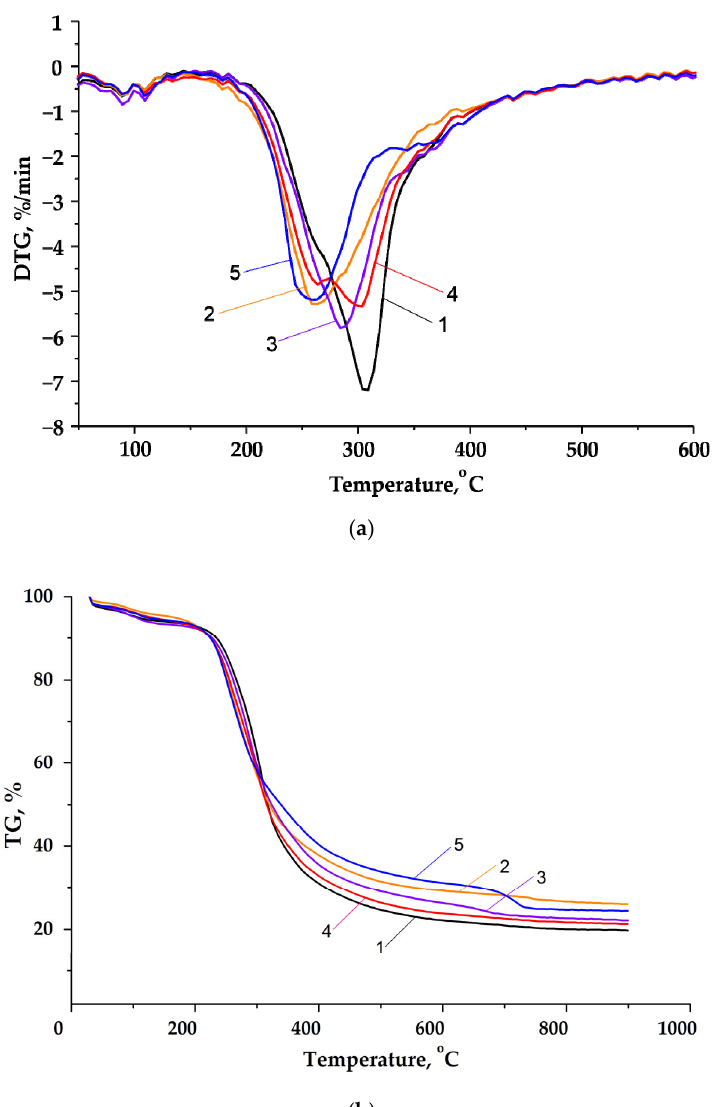
Figure 4. ( a ) DTG and ( b ) TG curves for the hemicelluloses extracted from the liquid products of the catalytic and noncatalytic delignification of spruce wood: (1) HC w/o cat , (2) HC Mo , (3) HC Mn , (4) HC Ti , and (5) HC H 2 SO 4